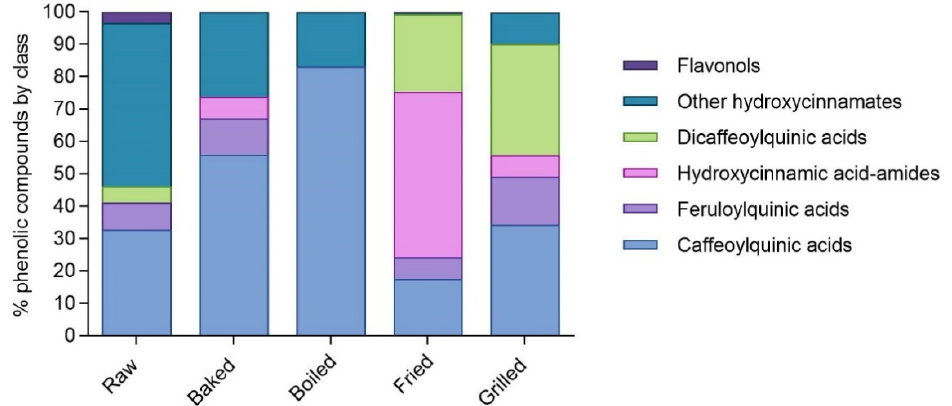
Figure 1. Percentage distribution of the main classes of phenolic compounds in raw and cooked in vitro digested dark purple eggplant phenolic-rich fractions. The percentage values are referred to the total concentration of phenolic compounds identified in the raw and cooked in vitro digested dark purple eggplant samples as reported in Table 1 and expressed as µ mol of compound/100 g of raw or cooked eggplant .